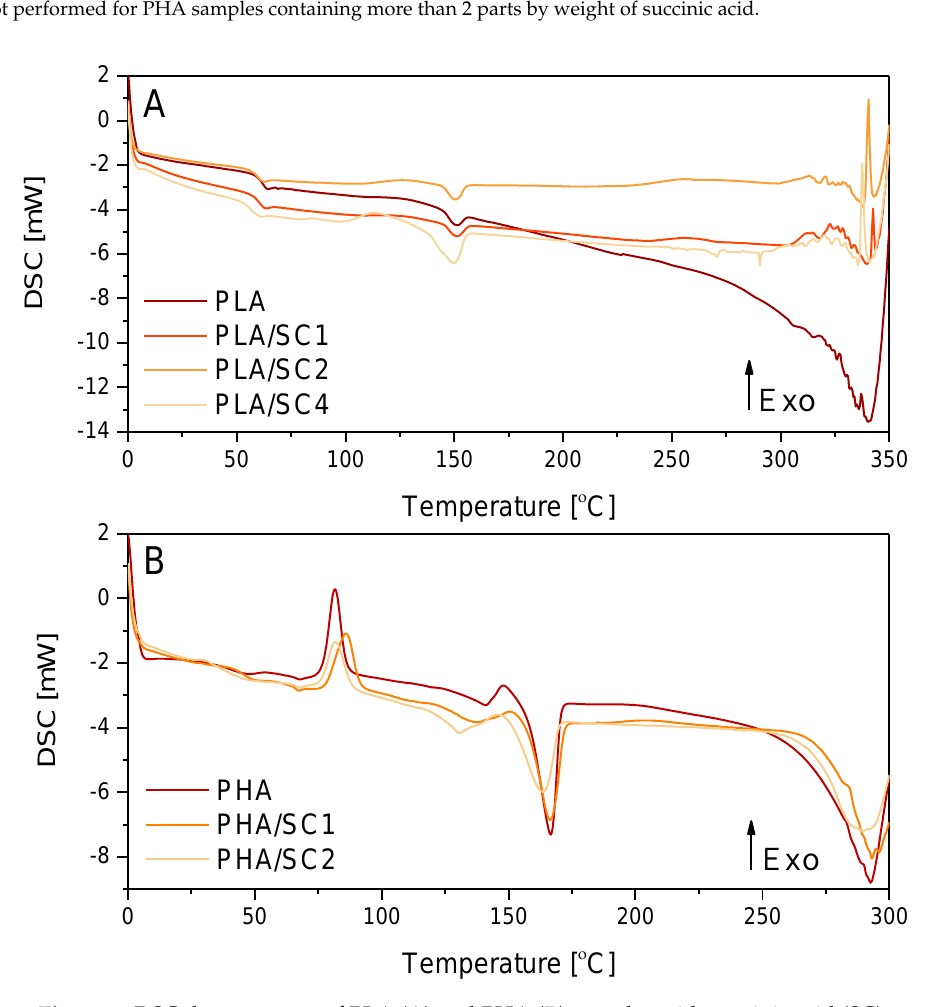
Figure 1. DSC thermograms of PLA ( A ) and PHA ( B ) samples with succinic acid (SC).